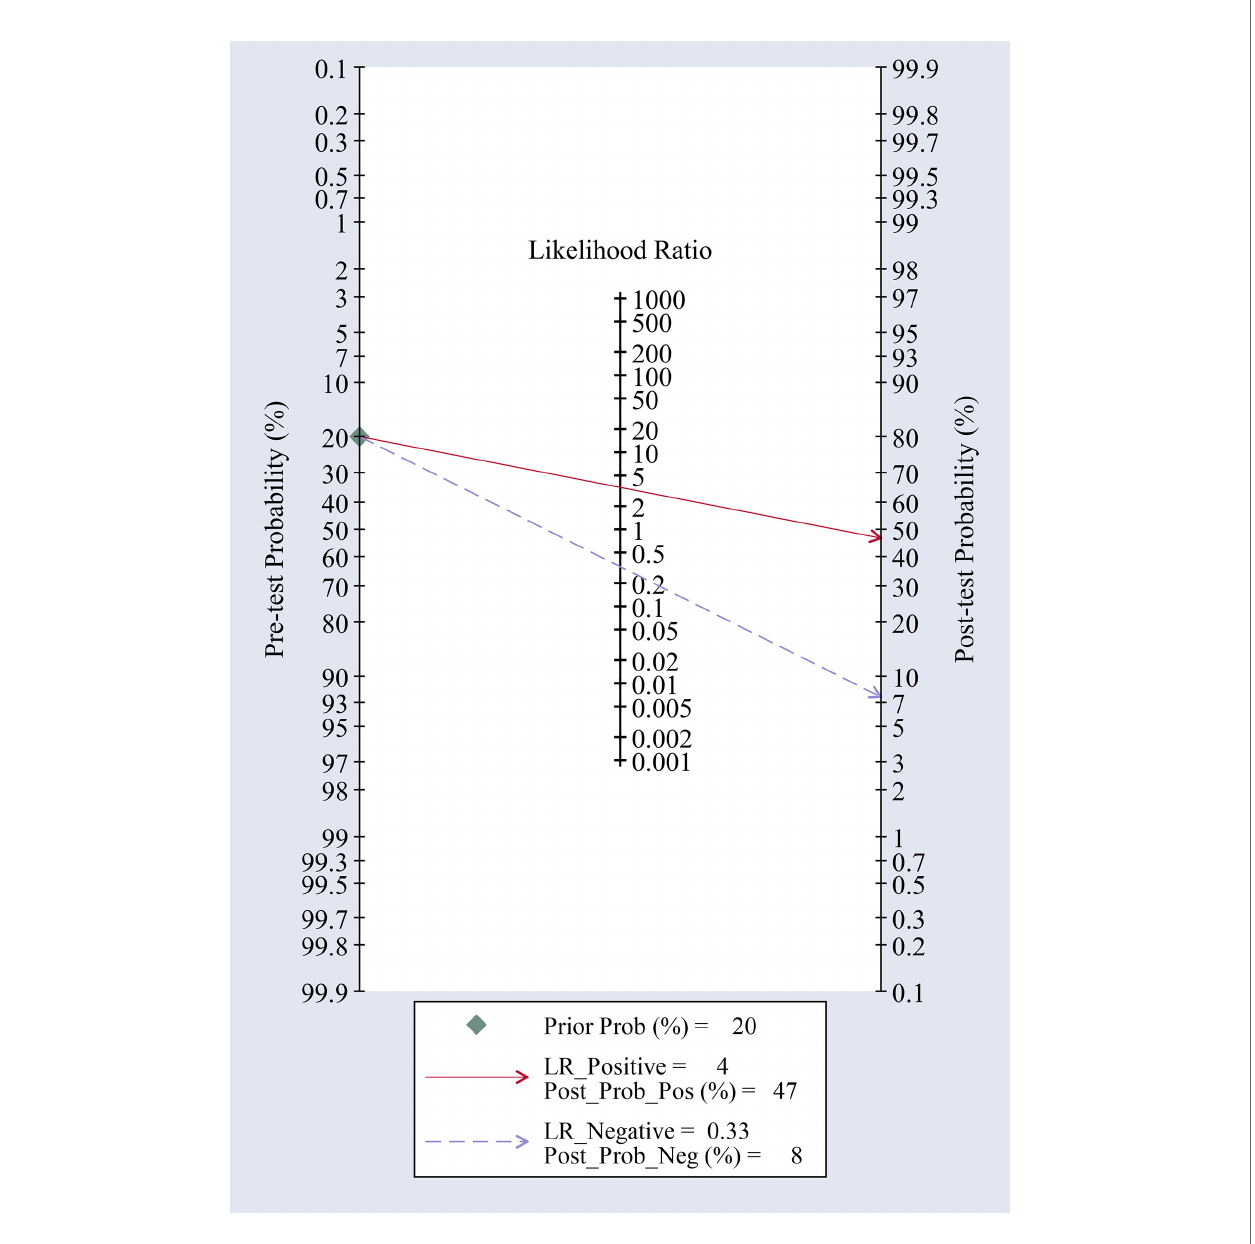
FIGURE 4 | Fagan ’ s nomogram for likelihood